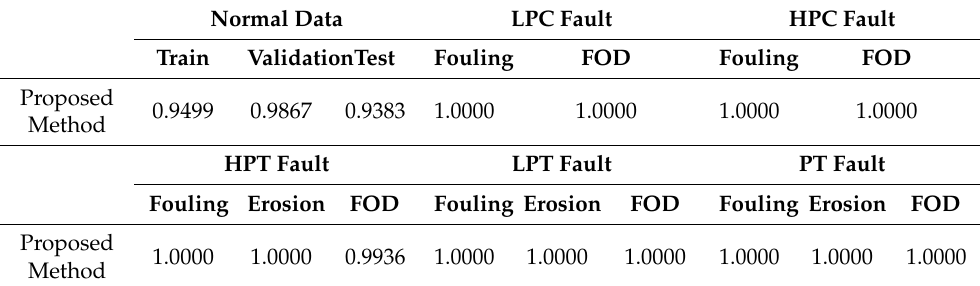
Table 5. Fault detection accuracy of the proposed normal pattern group